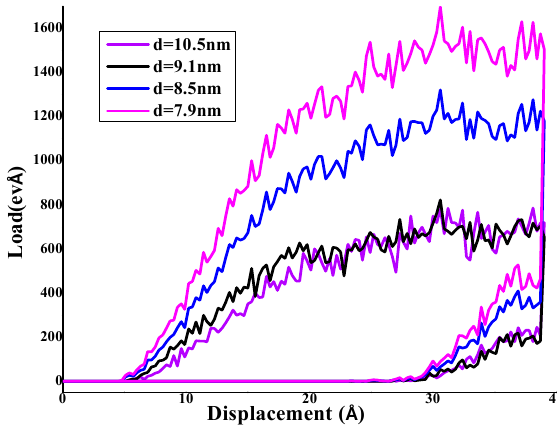
Figure 2. Load and unload displacement (P-h) line graphs for the nanocrystalline tungsten (W) uder a spherical nanoindentation along z at 300K and 3 Å/ps, the average grain size ranging from: 7.9 (color purple), 8.5 (color blue), 9.1(color black) and 10.5 (color